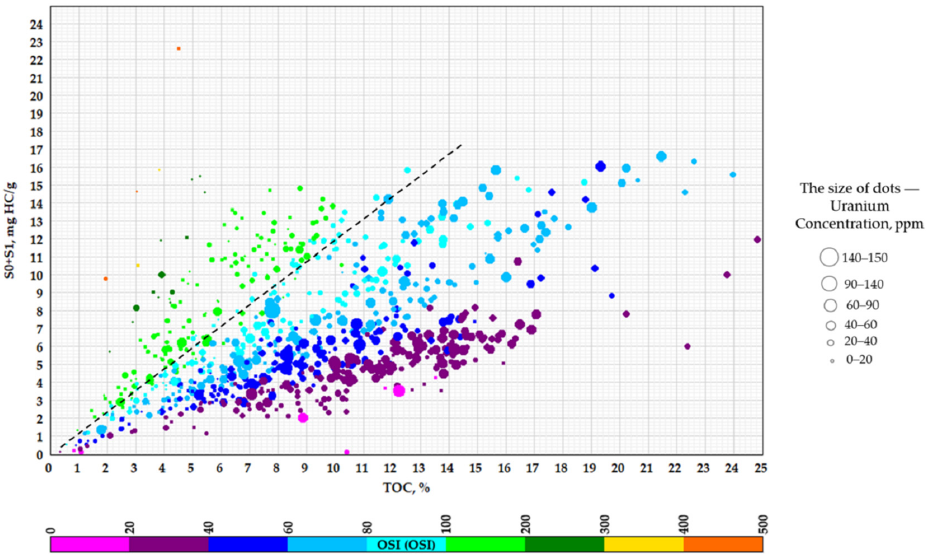
Figure 14. S 0 + S 1 − TOC diagram from pyrolysis studies of 11 wells, where color indicates OSI value and dot size reflects uranium concentration. The dotted line separates dots with OSI > 100 from other dots, for which OSI < 100 (see color fill).